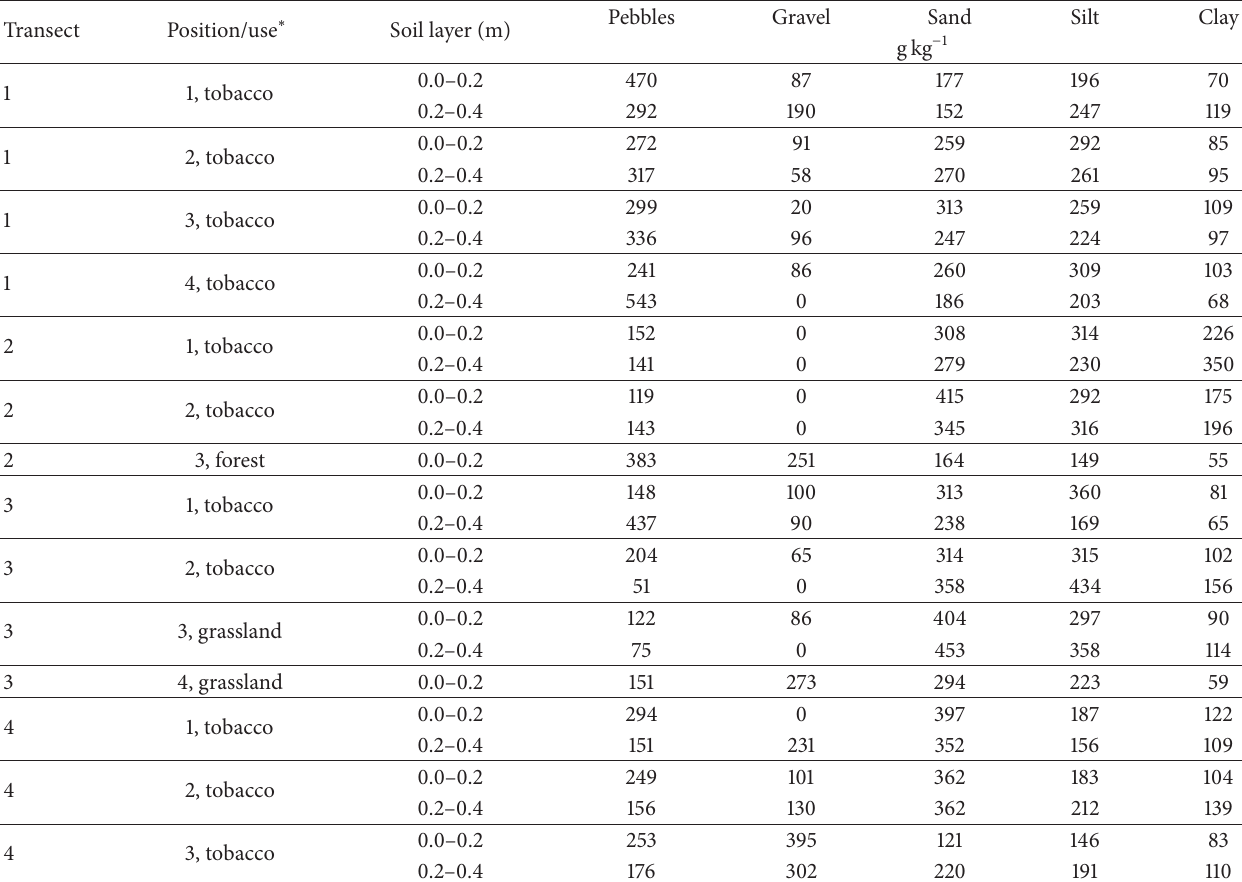
Table 1: Particle-size distribution in soil surface layer at sampling points, for five transects and different points in the watershed.